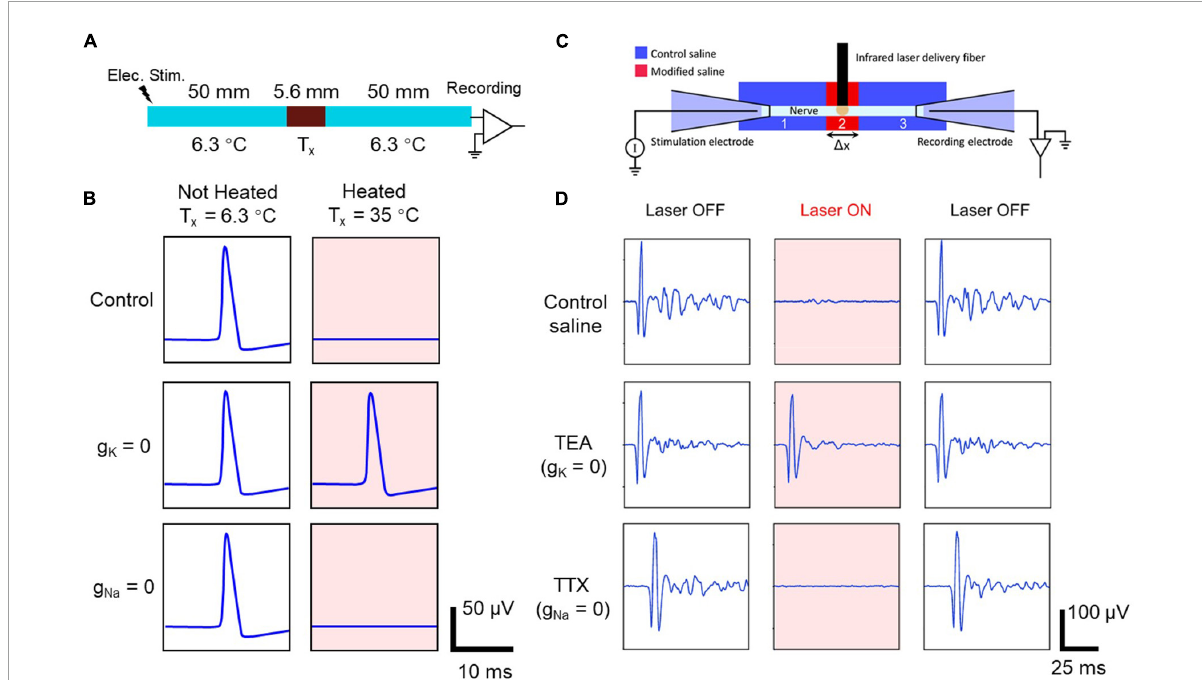
FIGURE5 Computational modeling (A,B) , and experimental validation in an Aplysia nerve (C,D) of the effect of blocking different ion channels on the heat-induced neural block. Panel (A) : A schematic of a model axon with a central region where the temperature can be locally elevated (representing the thermal effect during IR application) and where the ion channel conductance can be set to zero (representing the local application of an ion channel blocker). Panel (B) : The modeled action potential recordings under different conditions. Only when voltage-gated potassium channels are blocked ( g K = 0) is the heat-induced block effect reversed, allowing the action potential to propagate through the heated area and be recorded at the distal end of the axon (right hand pink panels), suggesting that the heat-induced block requires voltage-gated potassium channels. Panel (C) : An experimental schematic of an ex vivo electrophysiology test using an Aplysia nerve. IR light was applied to the central region of the nerve, which was also exposed to modified saline with different ion channel blockers. Panel (D) : The recorded CAPs during different combinations of IR light application and ion channel blockers. In agreement with the modeling prediction, only when TEA was applied to block the voltage-gated potassium ion channels was the IR neural inhibition effect reversed, allowing the action potential to propagate through the heated area and be recorded at the distal end of the axon. Reproduced from Ganguly et al., 2019a, b with permission. The original works are licensed under the terms of the Creative Commons Attribution 3.0 License and Creative Commons Attribution 4.0 Unported License, respectively. See license detail at https://creativecommons.org/licenses/by/3.0/ and https://creativecommons